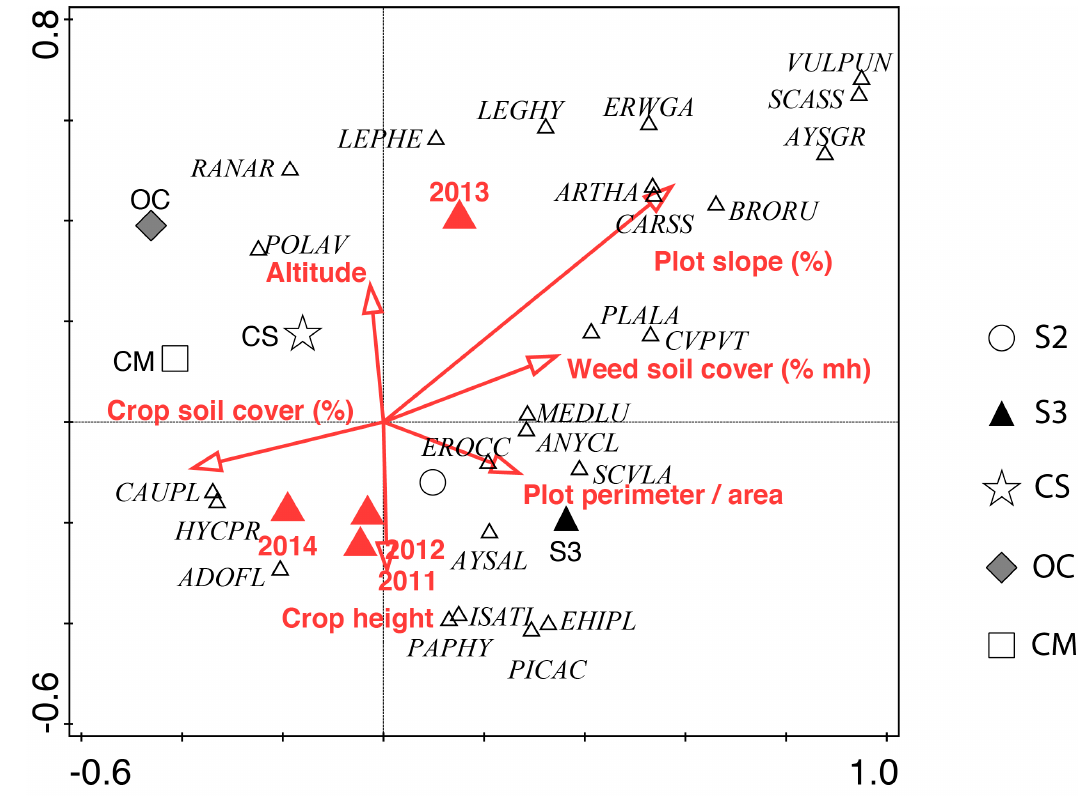
Figure 8. CCA analysis graph. CM: cereal monocrop, CS: cereal after sainfoin, OC: organic cereal, S2: sainfoin second year, S3: sainfoin third year.